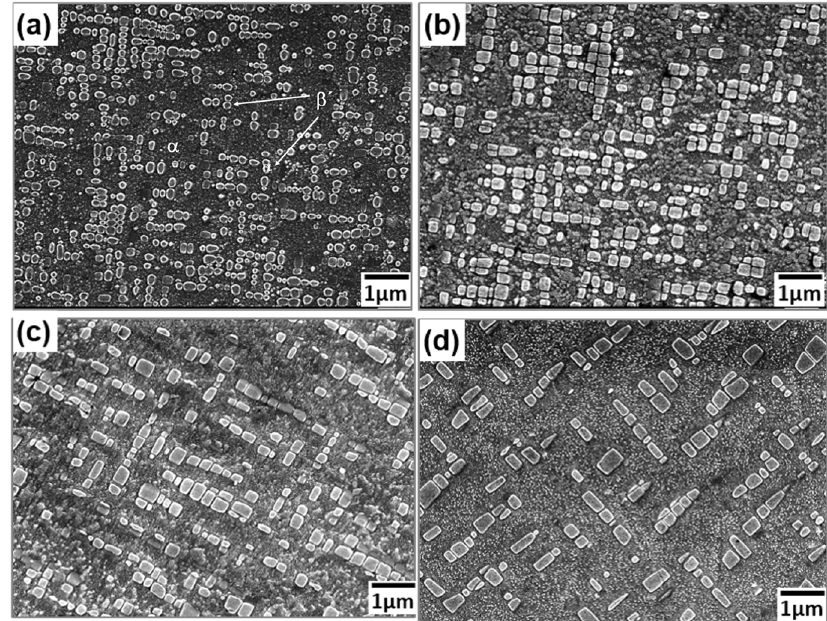
Figure 7. FEG-SEM micrographs of the precipitation evolution for the Fe-10at.%Ni-15at.%-2.5at.%CuAl alloy aged at 850 °C for (a) 10, (b) 25, (c) 50 and (d) 100